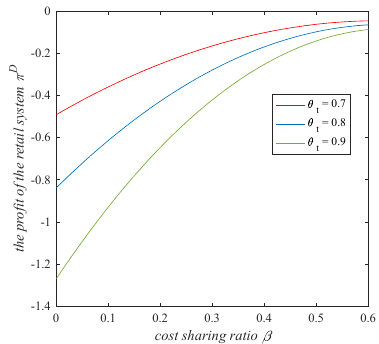
Figure 13. Profit of retail system in Scenario D (2).